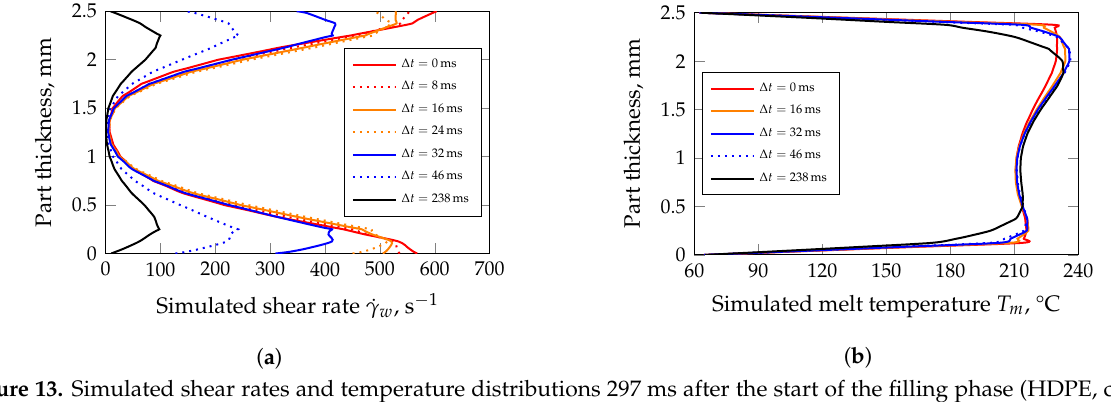
Figure 13. Simulated shear rates and temperature distributions 297 ms after the start of the filling phase (HDPE, center of the molded part). The time steps represent the decrease due to solidification processes at the cavity wall. Simulation parameters: (i) 20 elements in thickness direction, (ii) thermal conductivity of the mold λ S = 29 W m − 1 K − 1 , and (iii) heat transfer coefficient between steel, and melt of α = 5 kW m − 2 K − 1 . ( a ) Shear rates at the cavity wall decreases significantly after ∆ t = 24 ms. ( b ) Shear dissipation caused by the film gate leads to an increase in the average melt temperature of about 25